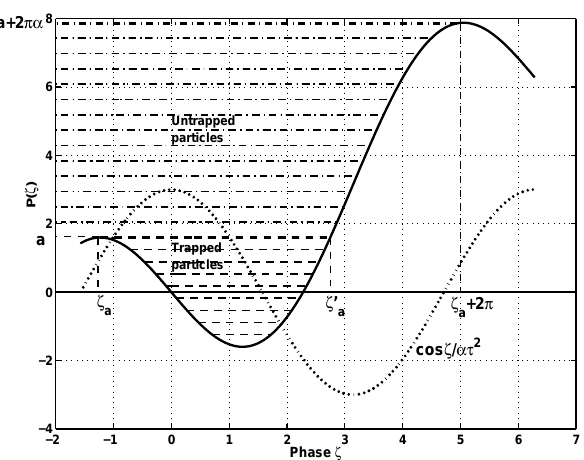
Fig. 1. Effective potential (14) for α > 0, with trapped and un- trapped particles. It is clearly seen that sign ( cos ζ) = − sign α for the majority of reflection coordinates of untrapped resonant parti- cles, which ensures that the energy variations for trapped and un- trapped particles have opposite